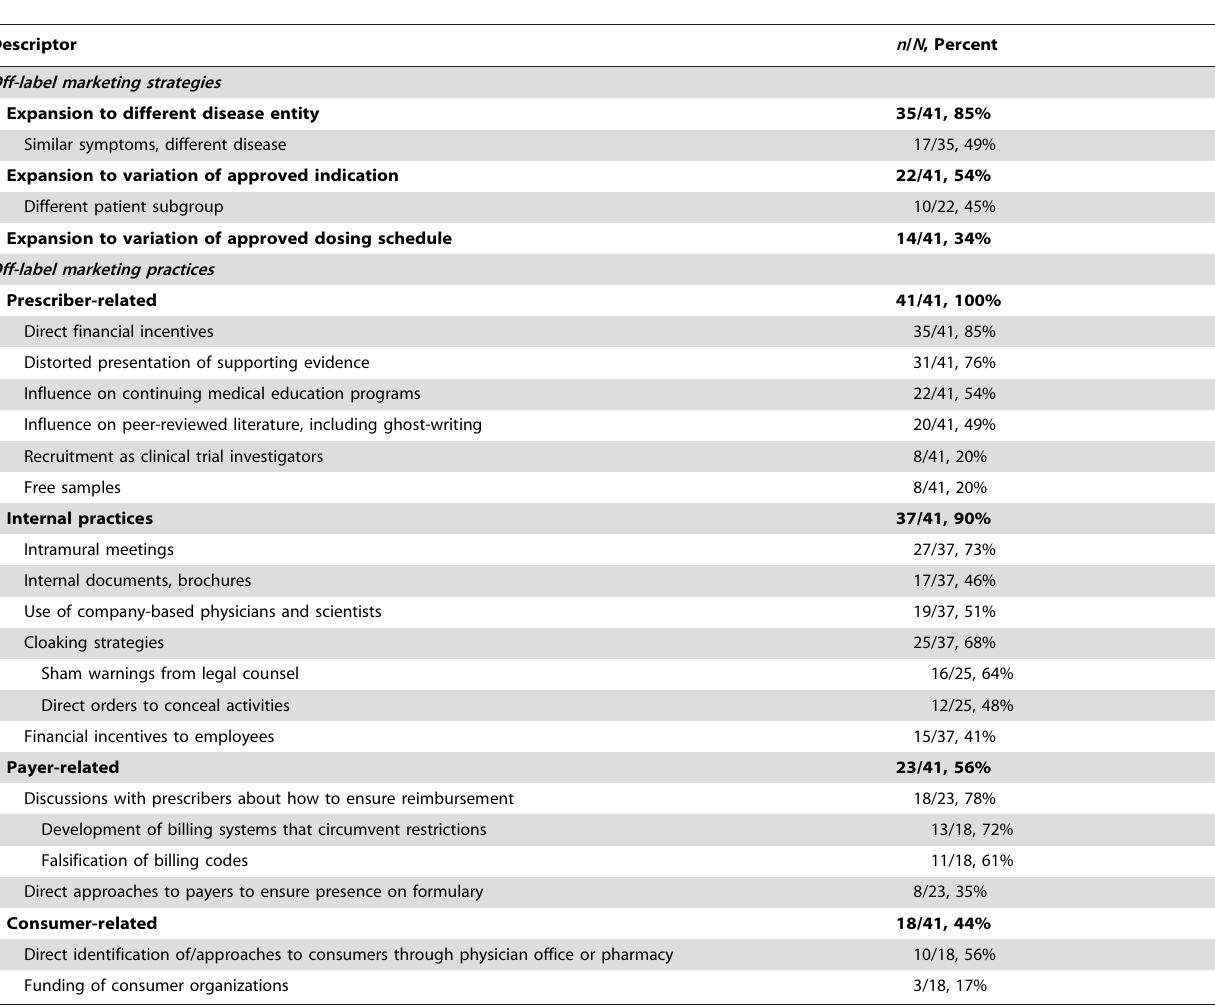
Table 2. Frequency of off-label marketing strategies and practices reported in whistleblower